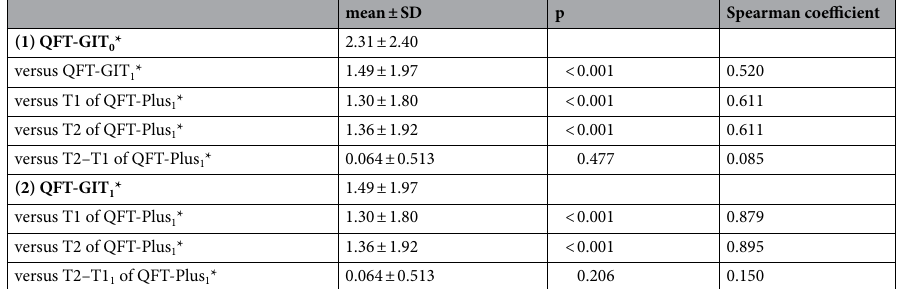
Table 2. The associations (1) between the interferon-gamma level of QuantiFERON-TB Gold In-tube (QFT- GIT) at baseline and at 1st follow-up with the QFT-GIT and QuantiFERON-TB Gold Plus (QFT-Plus) and (2) between the two tests at 1st follow-up. QFT-GIT response: the interferon-gamma level of the TB antigen tube minus the negative control. T1 or T2 response: the interferon-gamma level of the TB1 or TB2 tube, respectively, minus the negative control of the QFT-Plus test. All QFT responses are represented as IU/ml. *0: baseline test; 1: 1st follow-up, around 6 months later.